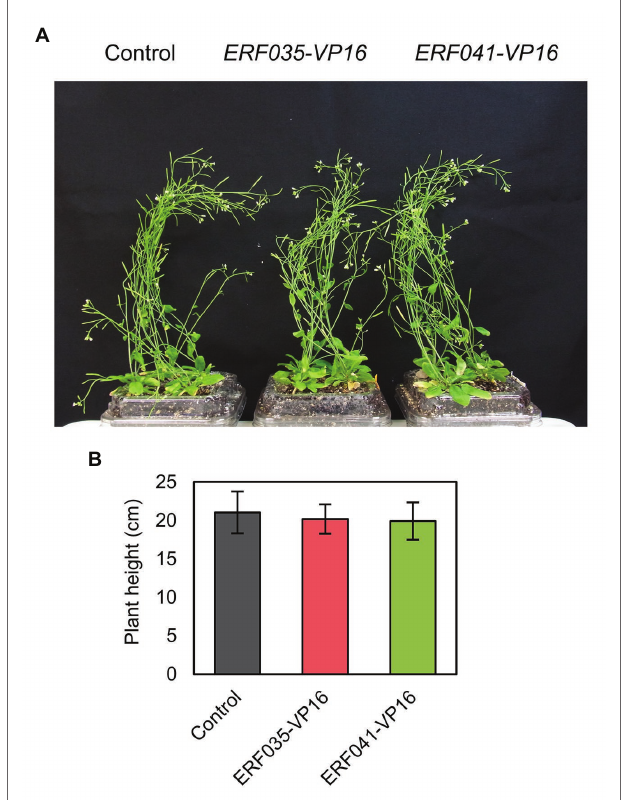
FIGURE 1 | Plant growth of ethylene response factor (ERF) IIId/e-VP16. (A) Whole image of the aerial part of T1 plants. (B) Plant height of primary stems 42 days after sowing. Data represent mean ±